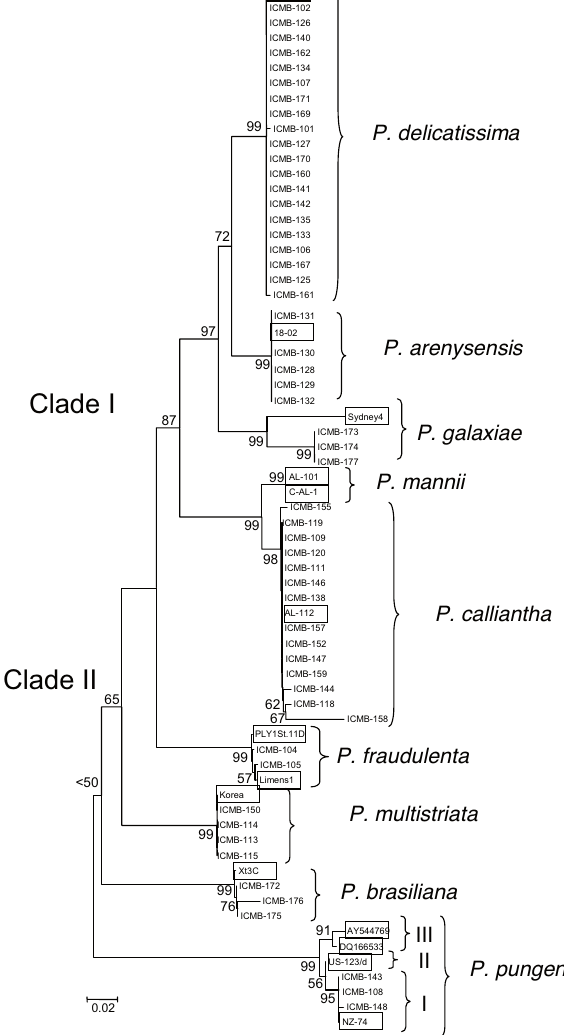
Fig . 4. – Neighbour-joining phylogenetic tree of several species belonging to the genus Pseudo-nitzschia , based on ITS–5.8S rDNA sequences. The names inside the box indicate ITS–5.8S rDNA se- quences from GenBank, while other sequences are from the NW Mediterranean Sea